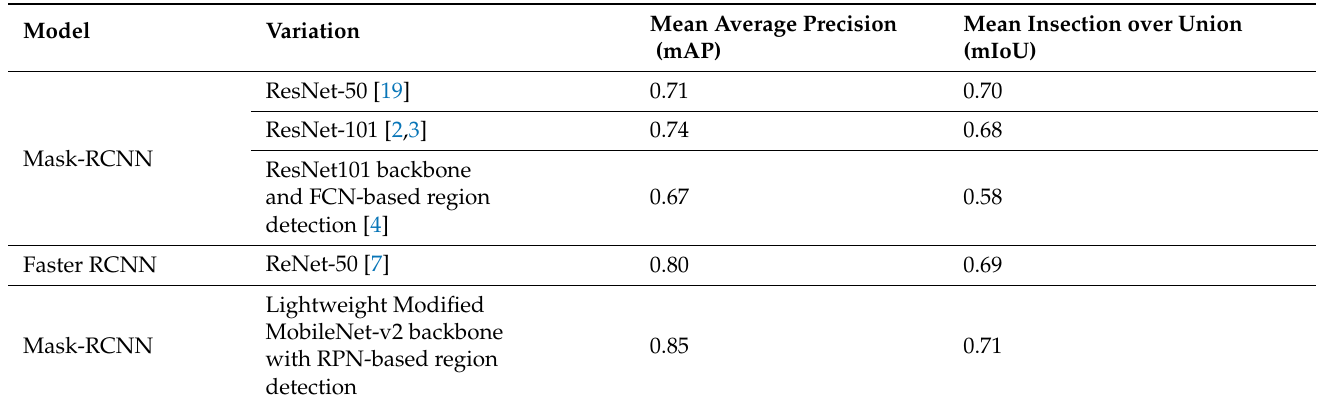
Table 5. Comparison of the measurement index of different networks for disease